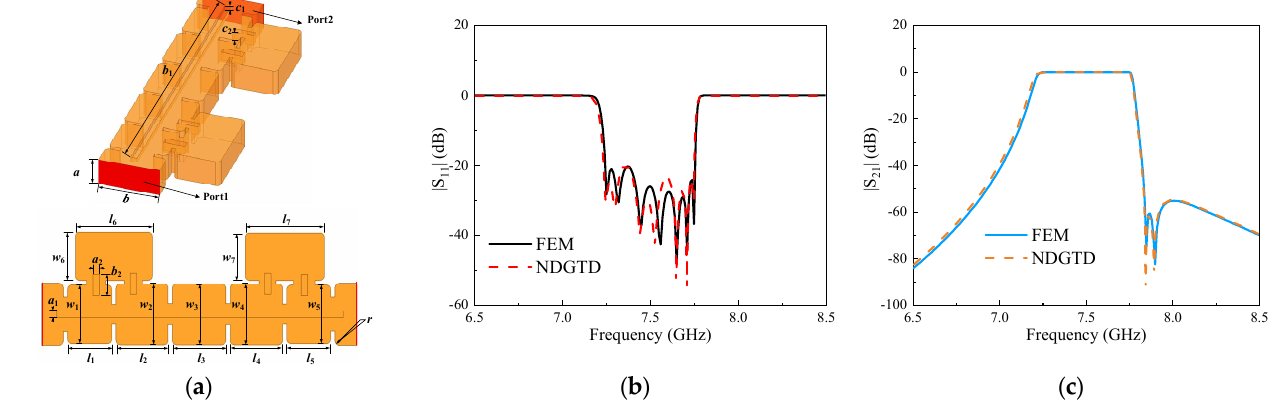
Figure 5. A 7th-order rectangular waveguide filter: ( a ) topology, ( b ) S 11 , and ( c ) S 21 . Dimensions of the wave port are b = 28.5 mm and a = 12.63 mm. The corner radius of cavities is r = 2 mm, and the other cavity sizes are l 1 = 20.35 mm, l 2 = 24.03 mm, l 3 = 24.58 mm, l 4 = 24.2 mm, l 5 = 20.2 mm, l 6 = 22.12 mm, l 7 = 21.8 mm, w 1 = w 5 = 27 mm, w 2 = w 3 = w 4 = 28 mm, w 6 = 35.5 mm, and w 7 = 36.5 mm. The sizes of the slots are a 1 = 3 mm, b 1 = 132 mm, c 1 = 2 mm, a 2 = 3 mm, b 2 = 10 mm, and c 2 = 4.82 mm.